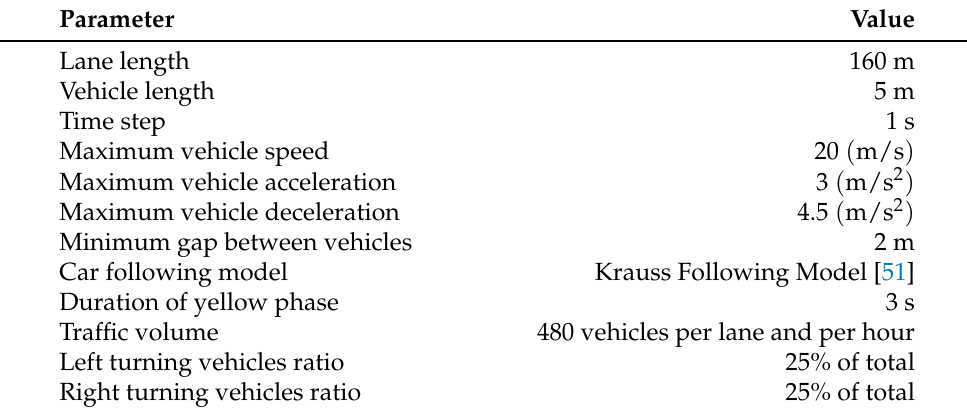
Table 1. Adopted parameters of simulation environment.